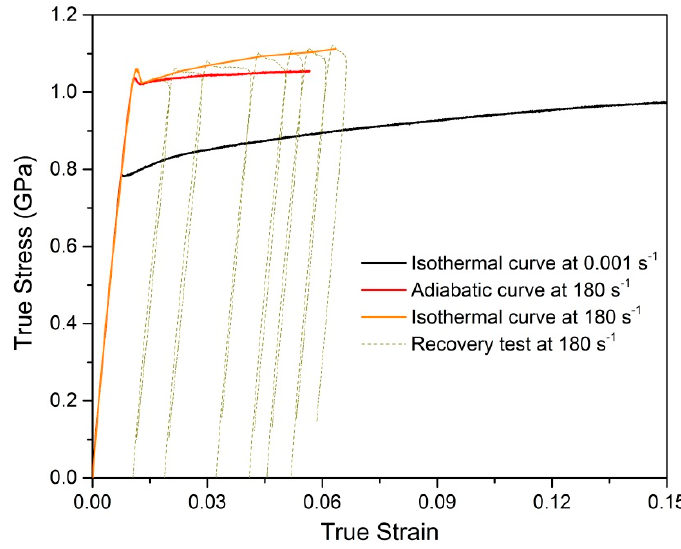
Figure 6. Comparison of isothermal and adiabatic responses.